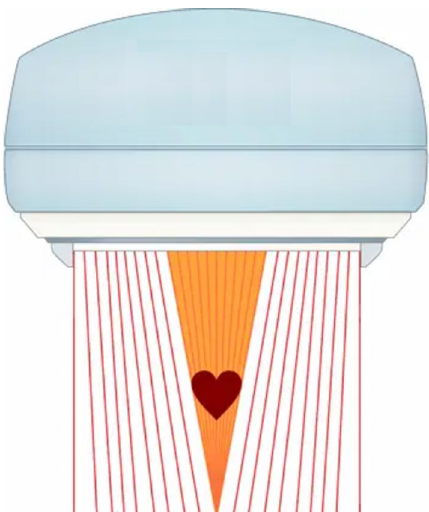
Fig. 1 Schematic depiction of the geometry of the cardiofocal SmartZoom collimator used in this